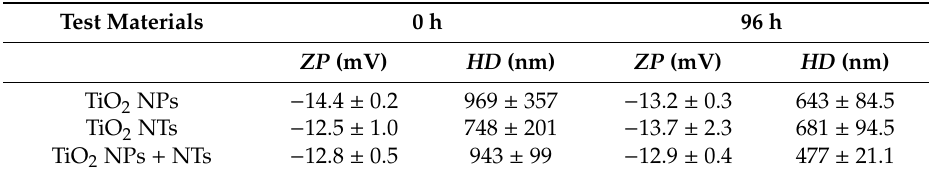
Table 1. Zeta potential ( ZP ) and hydrodynamic diameter ( HD ) ± standard deviation ( n = 3) of the test materials from single to binary mixture systems.